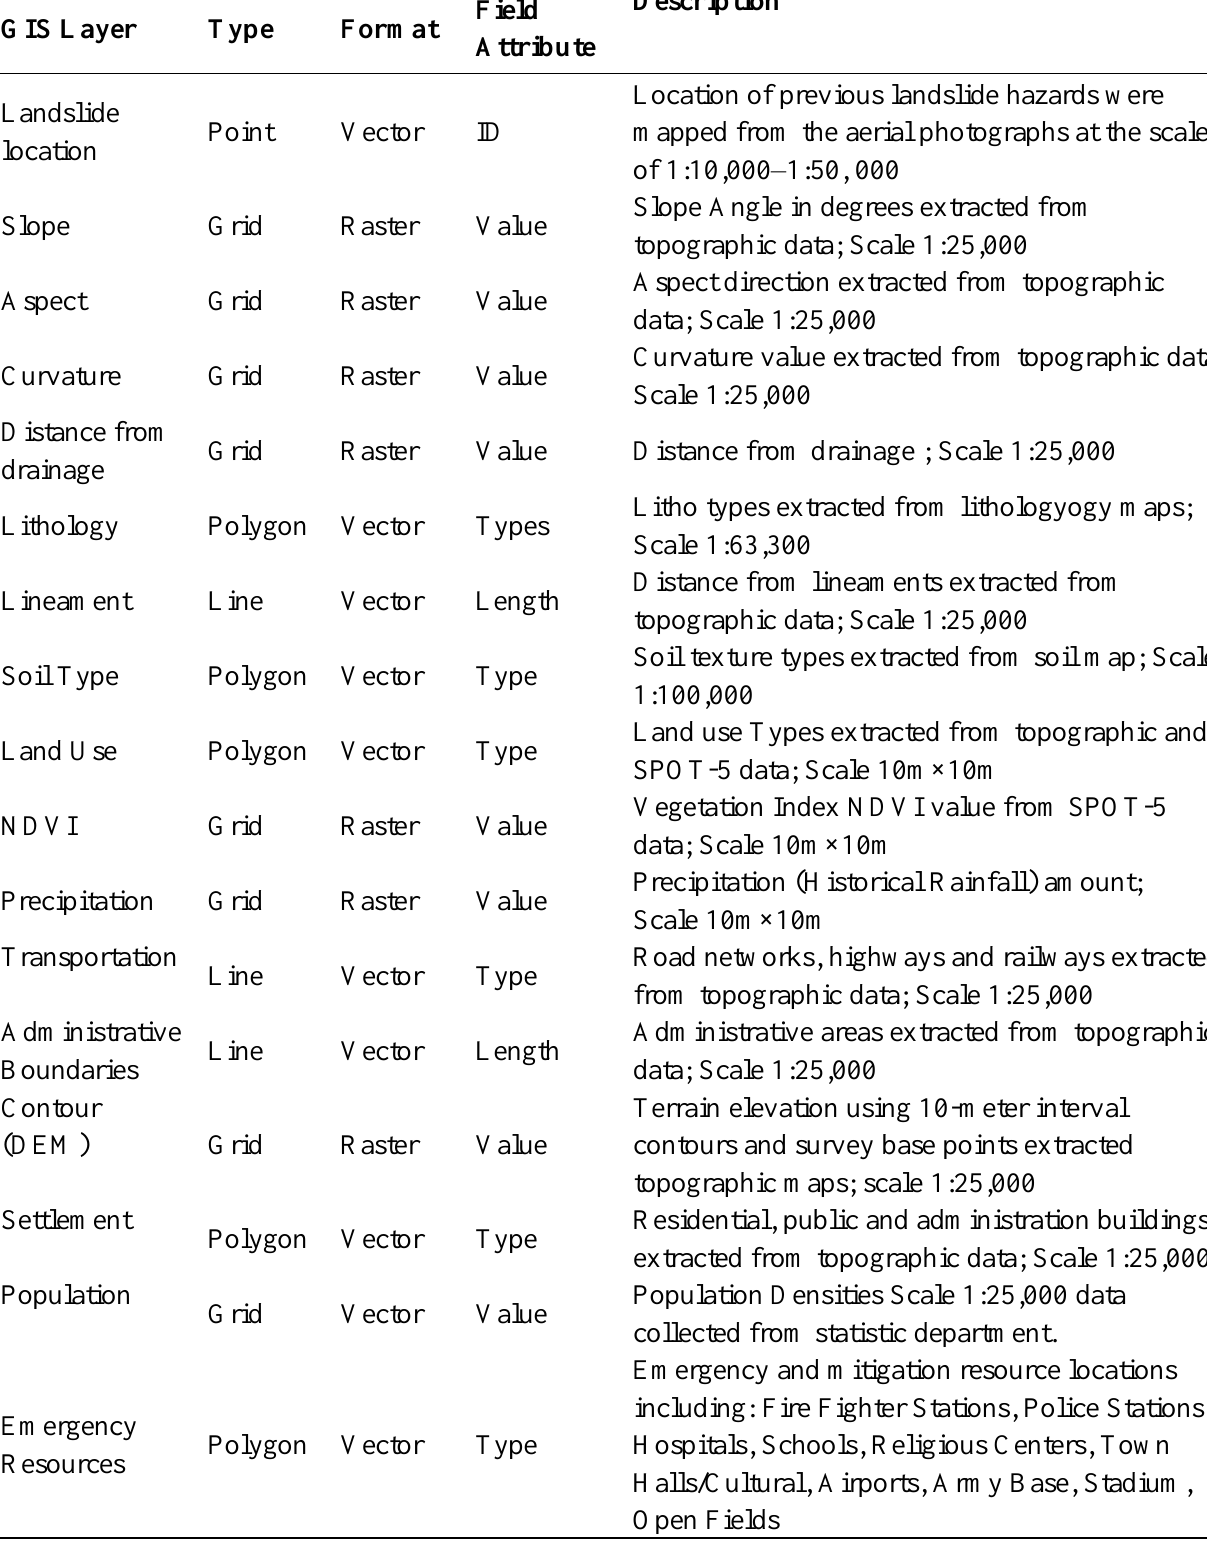
Table 1. General Database Stored in the Central Repository System